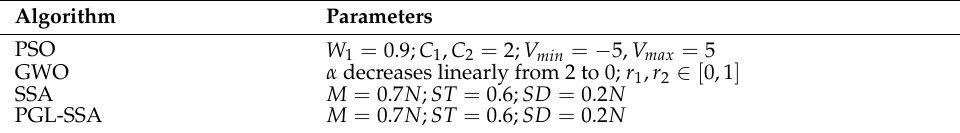
Table 2. Each algorithm parameter setting.